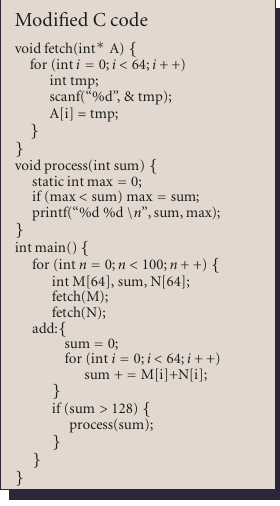
Figure 4: Modified sequential C code of Figure 2 illustrating the problem of a base variable A that can point to multiple